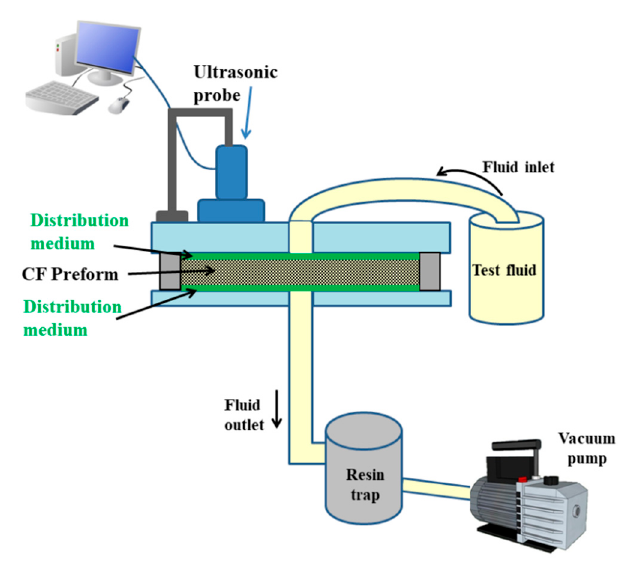
Figure 3. Experimental setup not in scale for transverse permeability measurements by ultrasonic wave propagation.